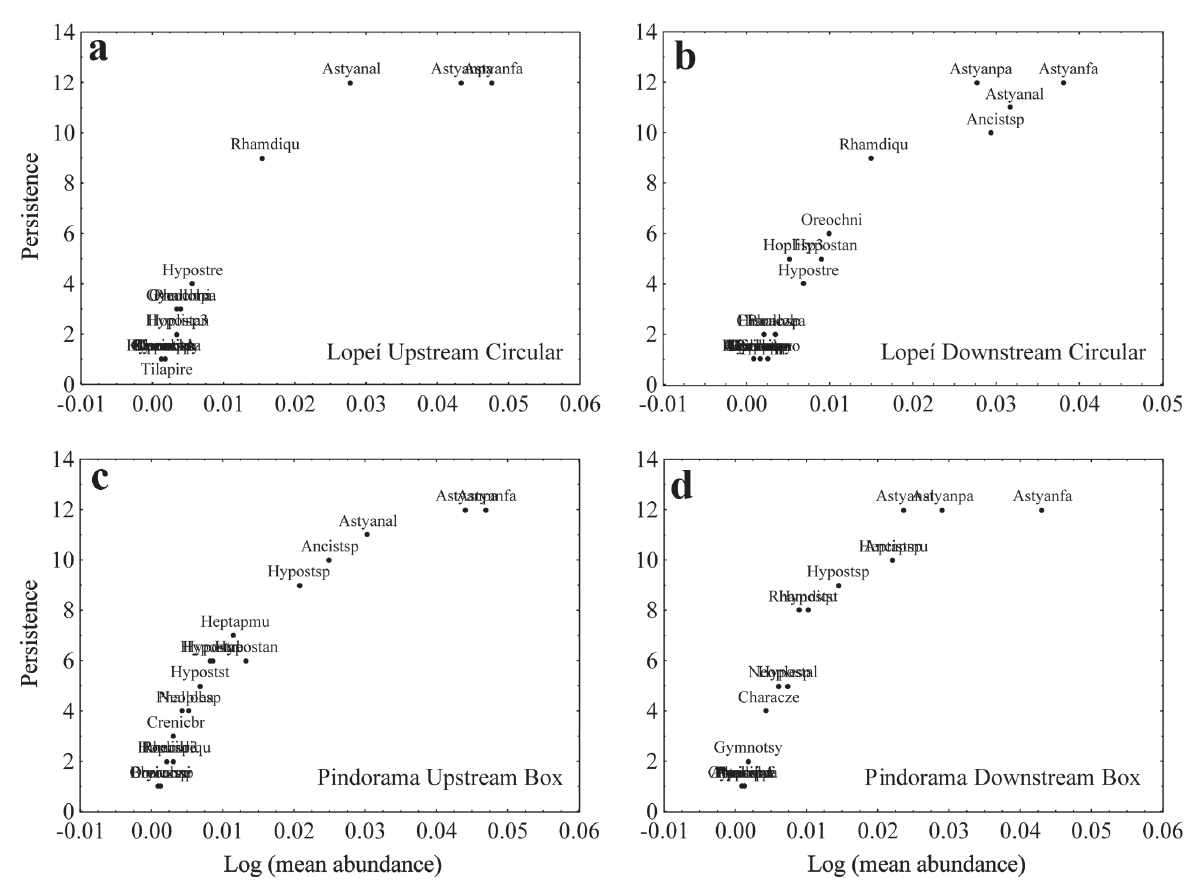
Fig. 11. Temporal persistence of the fish species in the sampled stretches of the Lopeí stream - circular culvert ( a - b ) and Pindorama stream - box culvert ( c - d